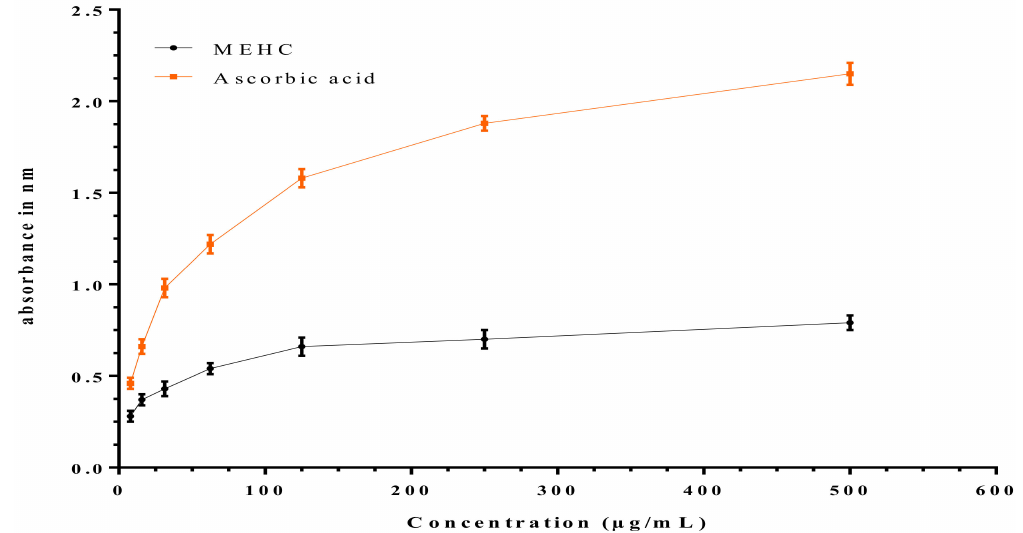
Figure 6. Reducing power capacity of ascorbic acid and MEHC. Values are expressed as mean ± SEM ( n = 3). MEHC refers to methanol extract of Holigarna caustica leaves.